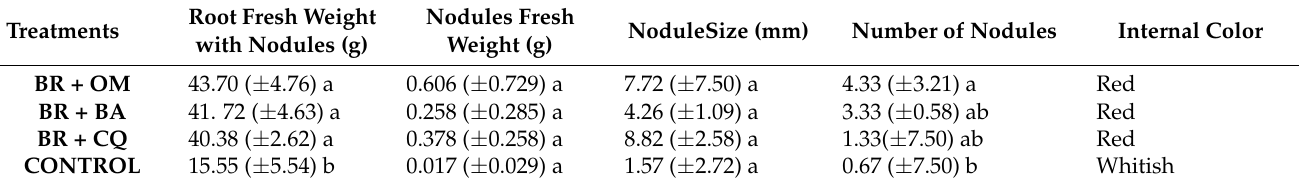
Table 6. Effect of treatments on nodular characteristics during flowering.